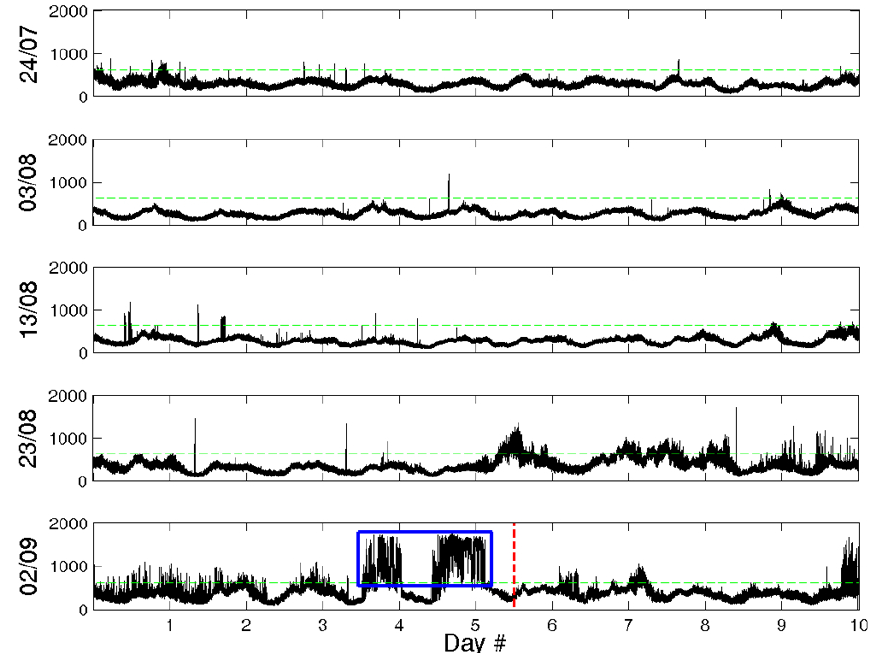
Fig. 4. Recordings of the magnetic field strength (in arbitrary units) from Zante station at 10kHz (direction East–West) for the time period from 24 July 1999 to 12 September 1999. The vertical red dashed line denotes the exact time of the Athens’ EQ occurrence ( M W = 5 . 9, 7 September 1999). The horizontal green dashed line indicates the considered background noise level. The blue frame (see Fig. 5a for a zoom on this part of the recordings) shows the couple of persistent strong burst-like EM emissions emitted just before the EQ occurrence. Note that fault model of this EQ predicts the activation of two faults with energy relation 80% to 20% (Kontoes et al., 2000). Interestingly, the second EM anomaly, contains approximately 80% of the total EM energy released, with the first one containing the rest 20%, while the same distribution holds for the entropy and information content of these two strong EM anomalies (see also Fig. 6) (Potirakis et al.,